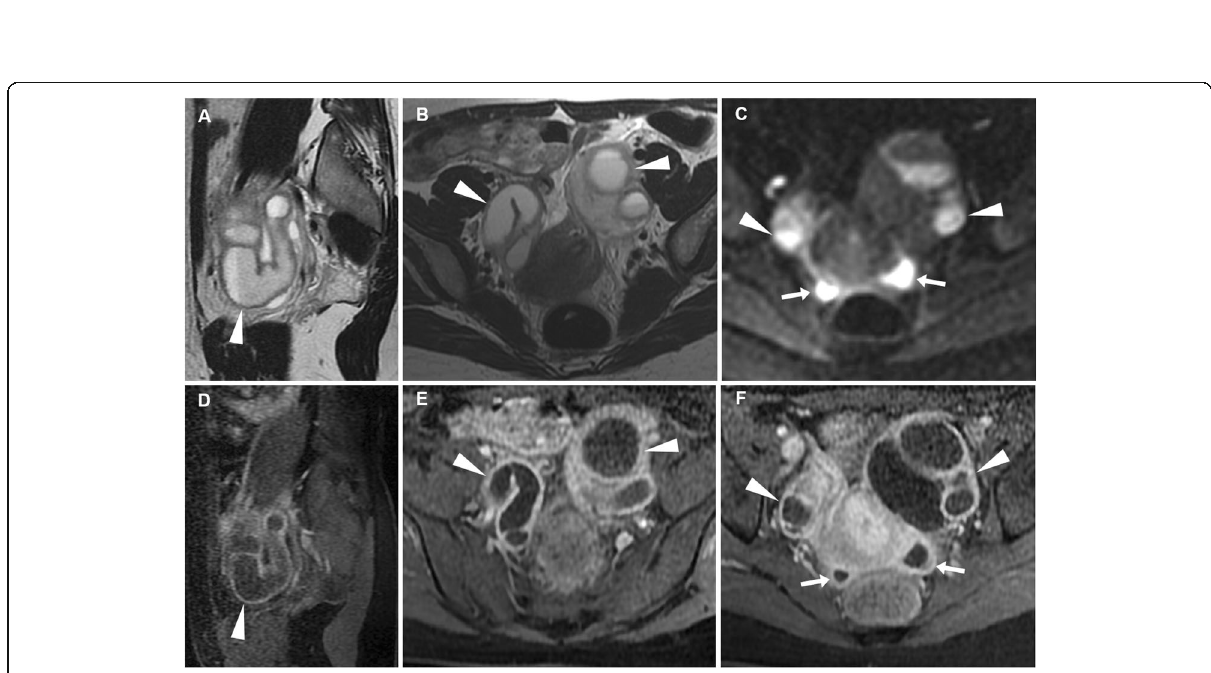
Fig. 14 Acute pyosalpinx in the same patient as Fig. 11. Sagittal ( a ) and oblique-axial T2-weighted ( b ) images show distended fallopian tubes (arrowheads) with thickened walls and internal fluid-fluid levels. Axial DWI ( b = 800 s/mm 2 ) image ( c ) demonstrates high signal intensity indicating restricted diffusion of the tubal content (arrowheads) and of two fluid collections in the Douglas pouch (arrows), reflecting purulent content. Sagittal ( d ) and oblique-axial gadolinium-enhanced fat-suppressed ( e , f ) T1-weighted images show intense mural enhancement of the involved Fallopian tube (arrowheads) and of the fluid collections